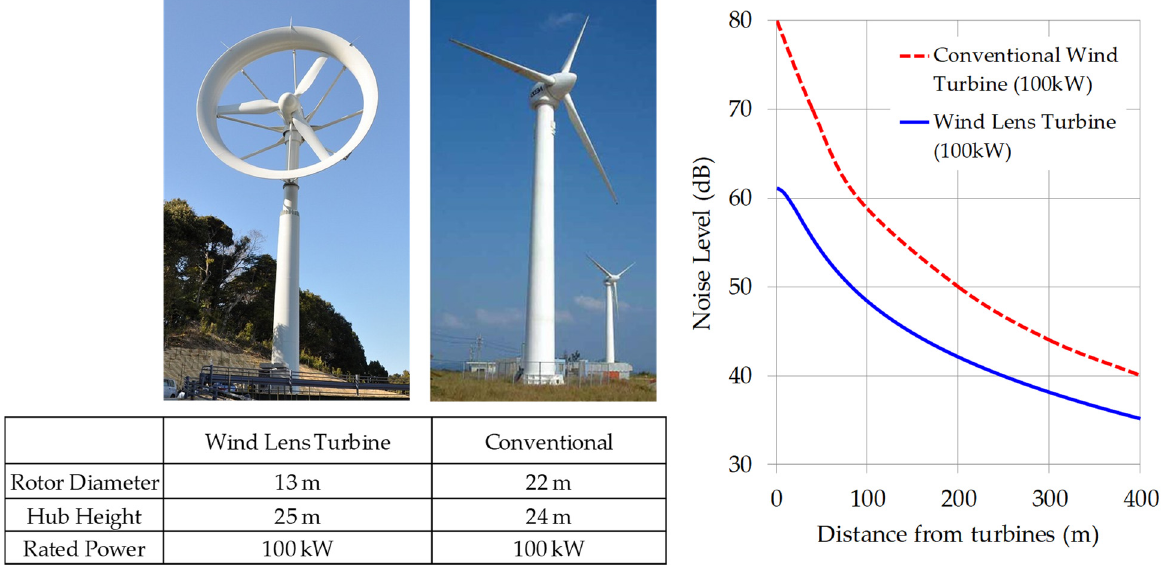
Figure 4. Field experiment of a 100 kW wind lens turbine (WLT) with a rotor diameter of 12.8 m and a lens diameter of 15.4 m. Adapted from ref. [20].